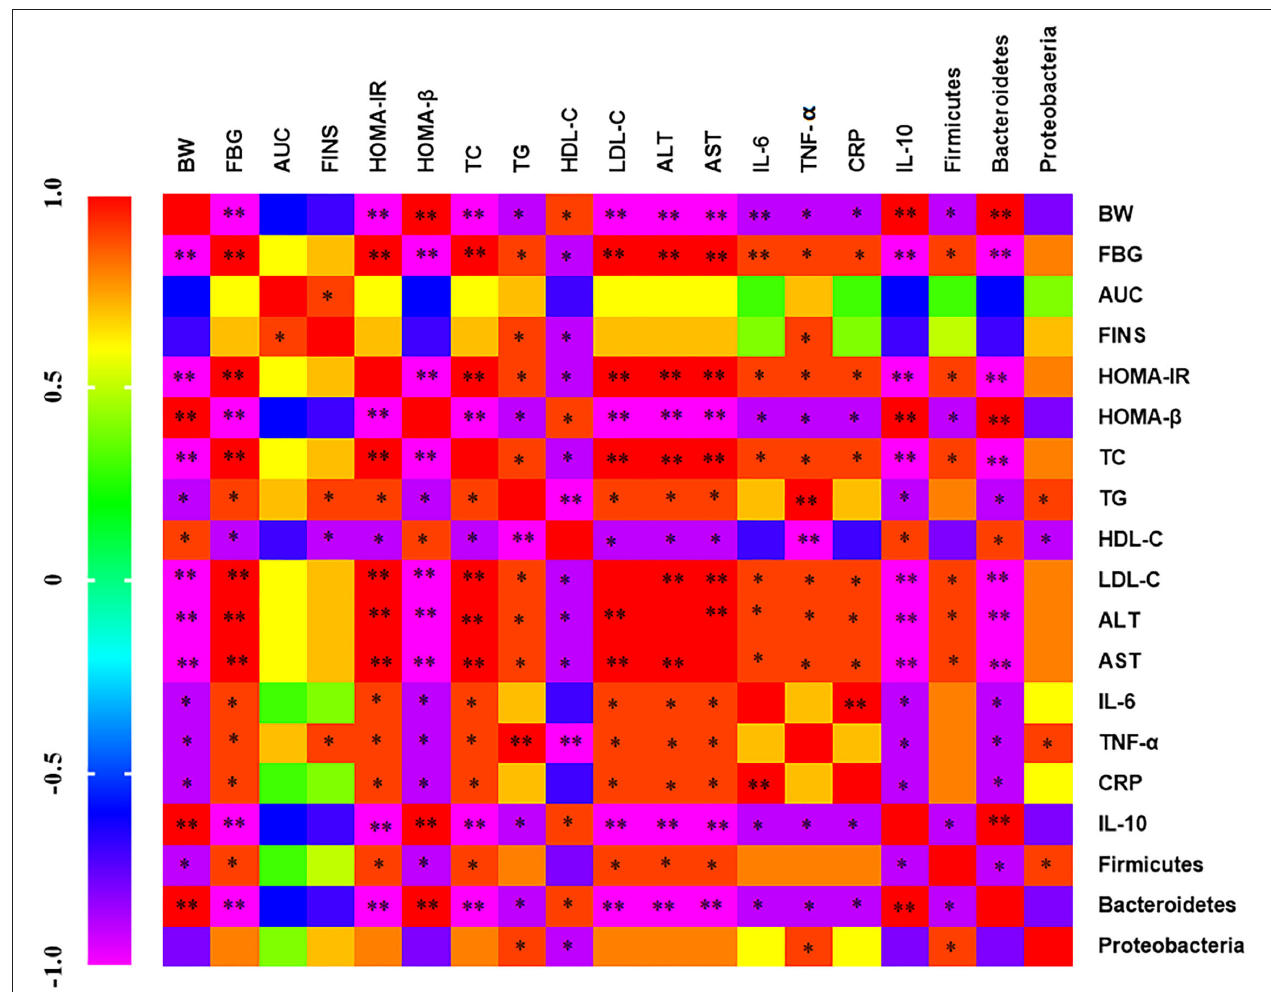
FIGURE 9 | Heat map of correlation analysis between serum inflammatory factors, intestinal flora, and metabolic indexes Purple indicates negative correlation and red indicates positive correlation.* p < 0.05 and ** p < 0.001,